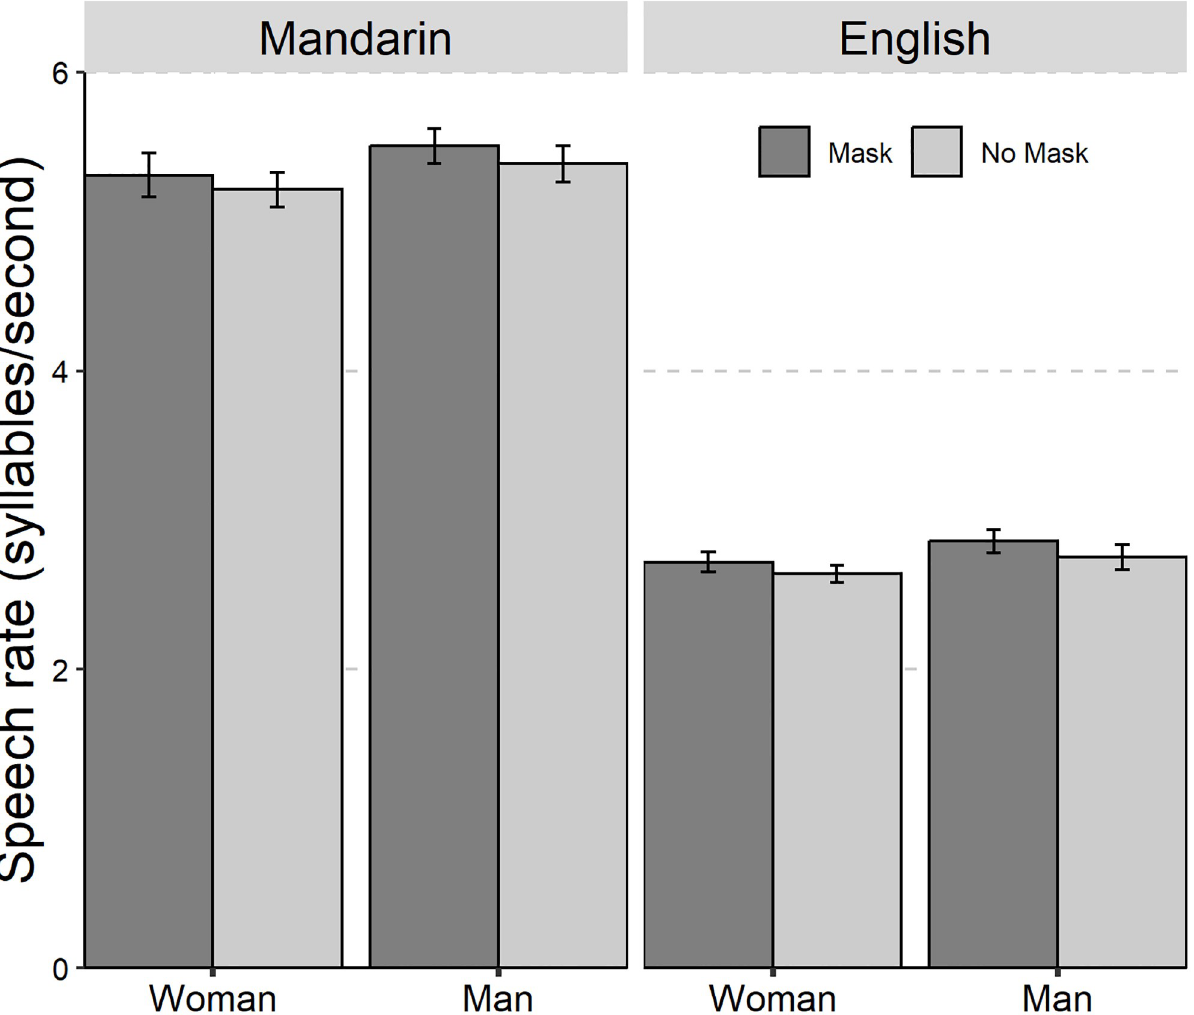
Fig 2. The bar plot (with standard error) of the speech rate (syllables/second) of Mandarin Chinese and English with and without mask across gender (female and male).